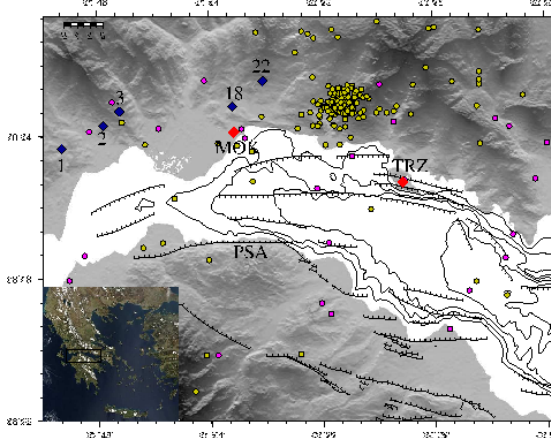
Figure 1. MapofthewesternpartofthegulfofCorinth(blacksquare, leftbottominsert)inGreece. Reddiamonds: sitesofbore- hole strainmeter (MOK) and dilatometer (TRIZ). Blue cir- cles : epicenters of 2010 Pyrgos earthquakes, M=5.3, ’18’: 18/01/2010 event, ’22’: 22/01/2010 event. Blue diamonds : epicenters of the 3 largest earthquakes in 2011, M=4 to 4.7, ’1’: 11/02/2011 event, ’2’: 07/08/2011 event, ’3’: 10/11/2011 event. Epicenters from the February swarm are plotted as yellow circles. Epicenters for julian day 339 (05/12) are represented by the purple circles (cf part. 4.3.). The scale (in kilometer) is representated on left